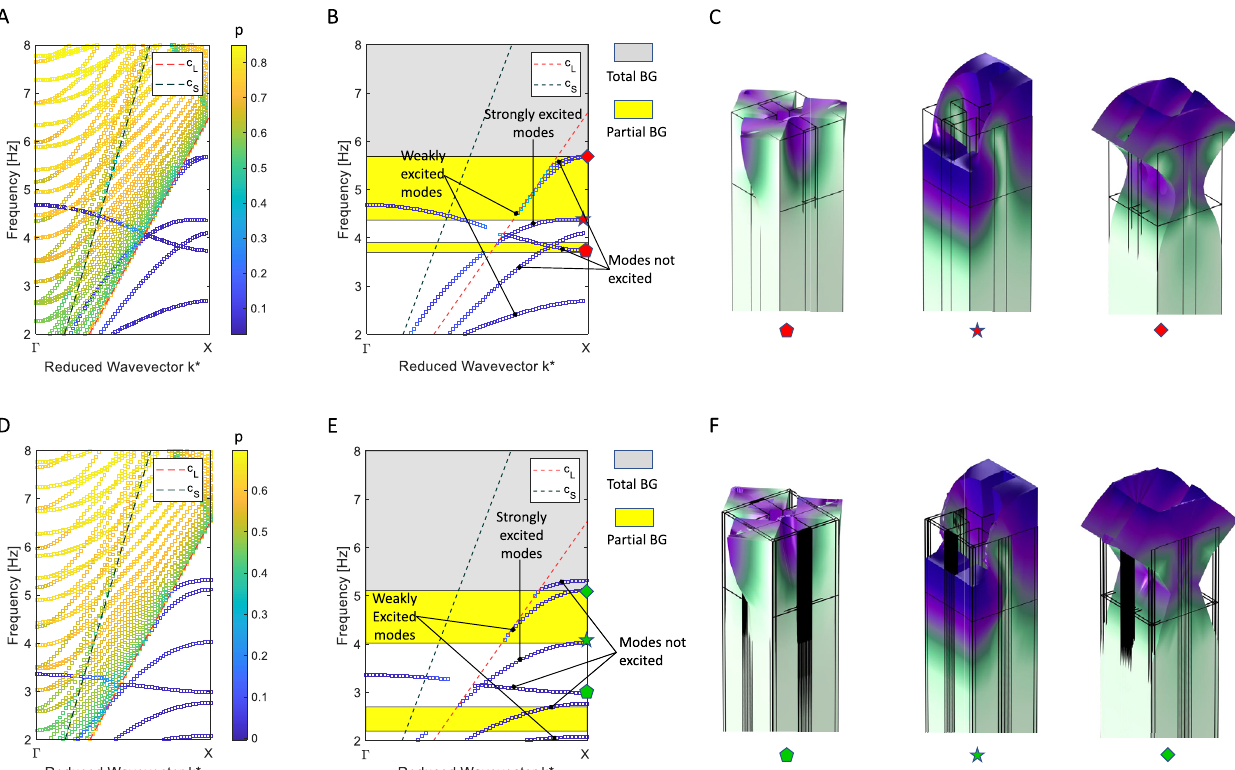
Fig. 3. Dispersion diagrams II − free/half-space assumption. Row dispersion diagrams deriving from the Bloch-Floquet calculations for the (A) ordinary and (D) hierarchical large-scale metamaterial, under the hypothesis of free boundary condition applied to the top surface of the unit cell and semi-in fi nite half-space modeled through 8 l -long soil-like domain+ a 2 l -long PML region on the bottom surface of the unit cell. Curves are color-coded allowing to highlight modes localized at the surface ( p (cid:3) 0.3) and those radiating in the bulk ( p > 0.3). (B, E) Dispersion diagrams reporting only the modes localized at the surface for the dispersion diagrams reported in (A) and (D), respectively. Total and partial BGs are reported as grey and yellow rectangles, respectively. (C, F) Mode shapes with predominantly out-of-plane, in-plane and mixed polarization are indicated with corresponding symbols in the (B, E) band